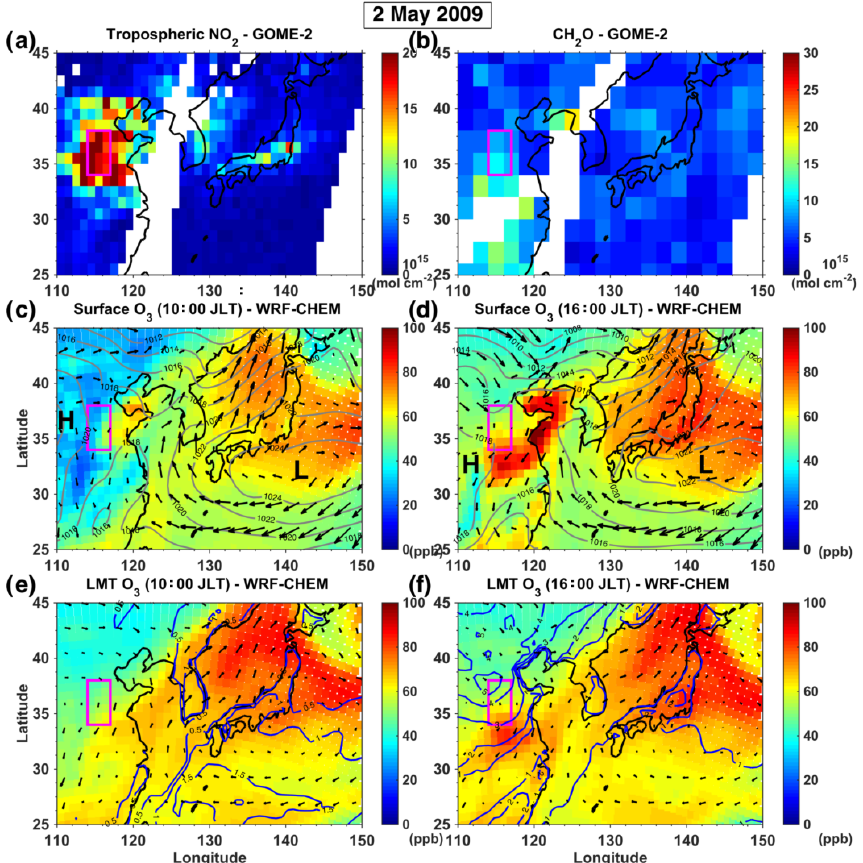
Figure 4. (a) Tropospheric nitrogen dioxide (NO 2 ) and (b) formaldehyde (CH 2 O) distribution over East Asia on 2 May 2009 derived from GOME-2 observations at 09:30JLT. (c–f) Ozone distribution simulated by the WRF-Chem model at the surface (panels c and d ) and averaged below 3km a.g.l. (LMT, panels e and f ) in the morning (at 10:00JLT, panels c and e ) and in the afternoon (at 16:00JLT, panels d and f ). Iso-contours in grey (panels c and d ) and dark blue ( e and f ) are mean sea level pressure (in hPa) and mixing boundary layer height (in kma.s.l.) from ERA-I reanalysis. Arrows depict winds at the surface (c, d) and 850hPa (e, f) from ERA-I. Low and high-pressure systems are indicated by respectively “L” and “H” (in panels c and d ). Magenta rectangles in panels indicate the overall location on 2 May 2009 of the tracked air masses during the ozone pollution outbreak of early May